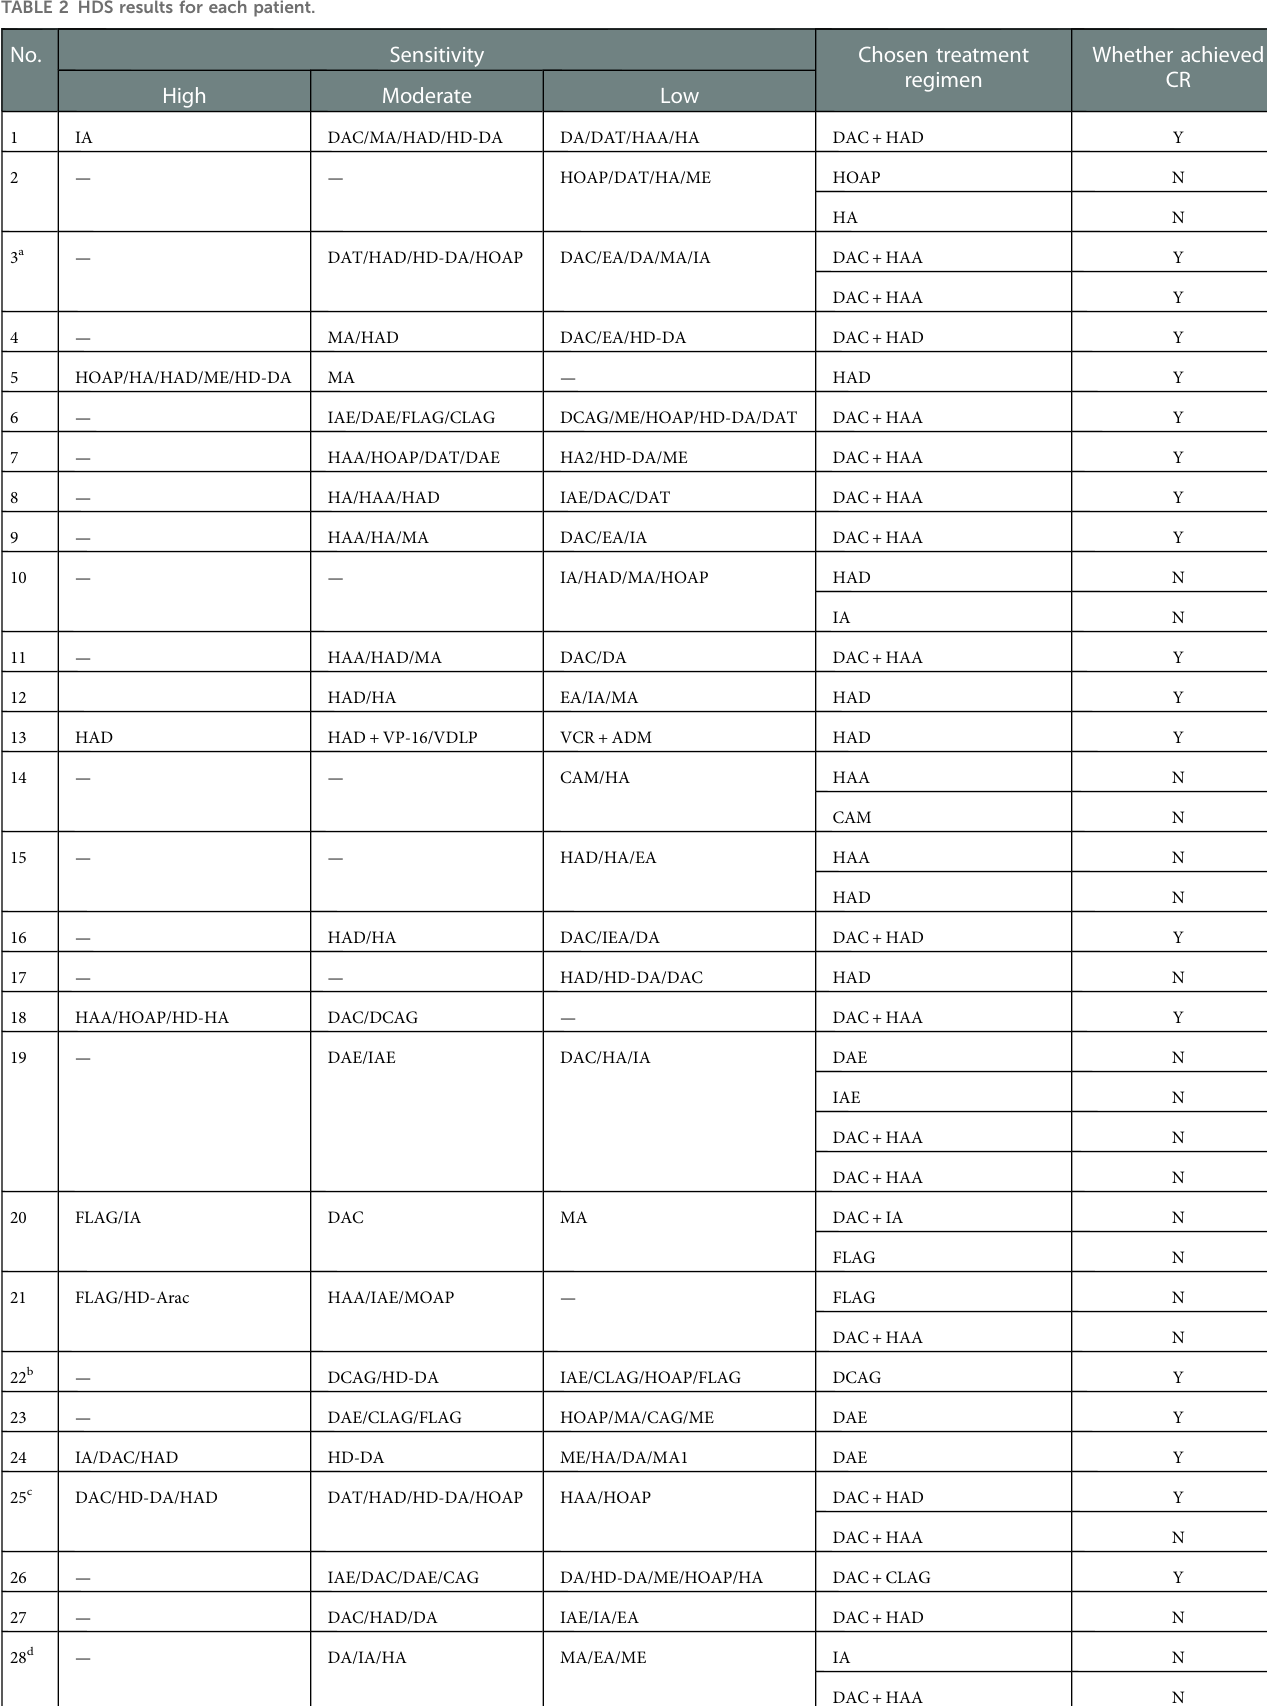
TABLE 2 HDS results for each patient.